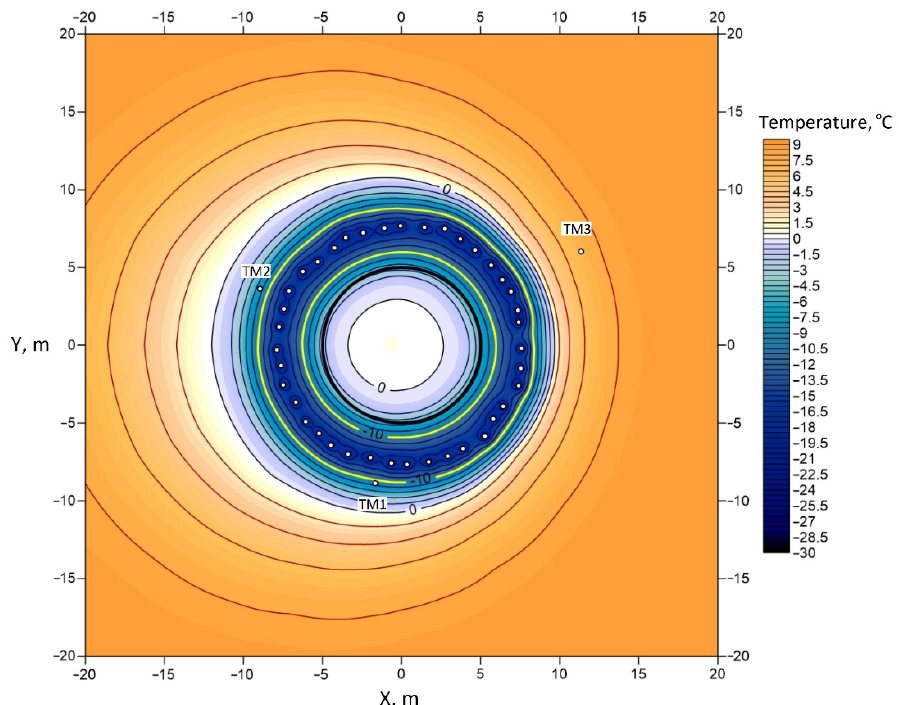
Figure 4. Calculated temperature distribution in the sand layer at a depth of 138 m with a filtration rate of 30 mm/day (date: 1 July 2021).